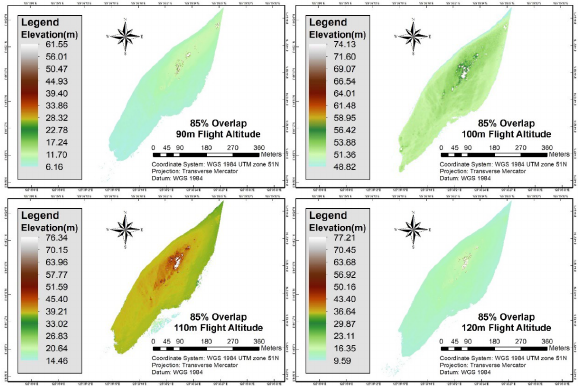
Figure 8 . Digital Terrain Models (DTMs) at 85% overlap generated using the acquired UAS data and disabled interpolated setting. The white areas implied “no data ” pixels.